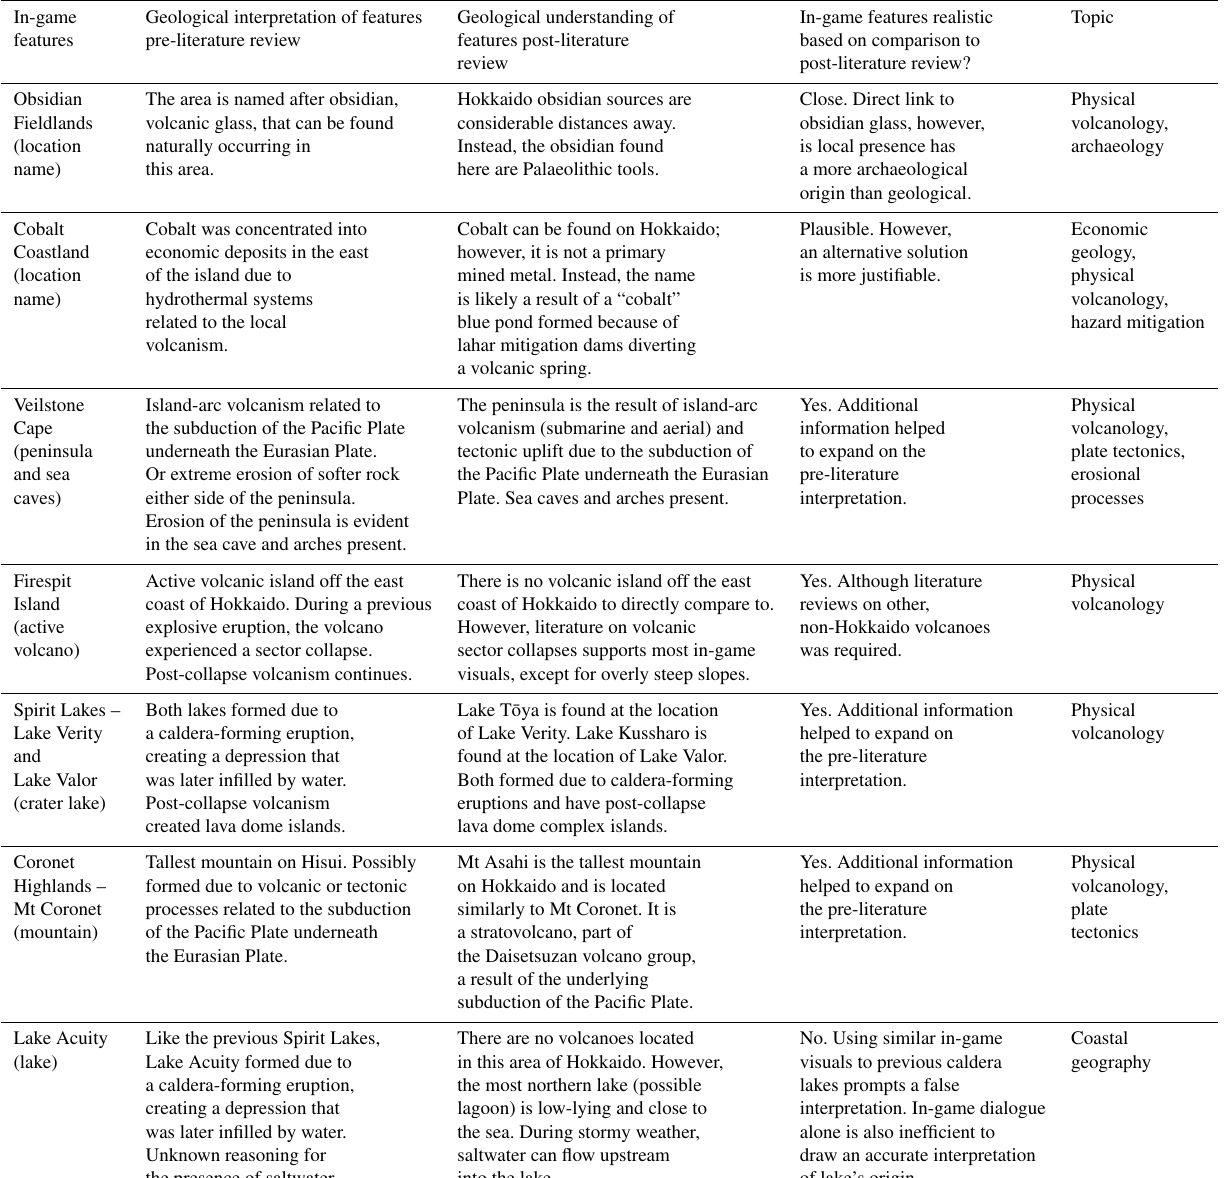
Table 1. Summary of author interpretations of the geological and geomorphological features selected within Pokémon Legends: Arceus , based on in-game visuals or prompts, versus the geological understanding of the features post-literature